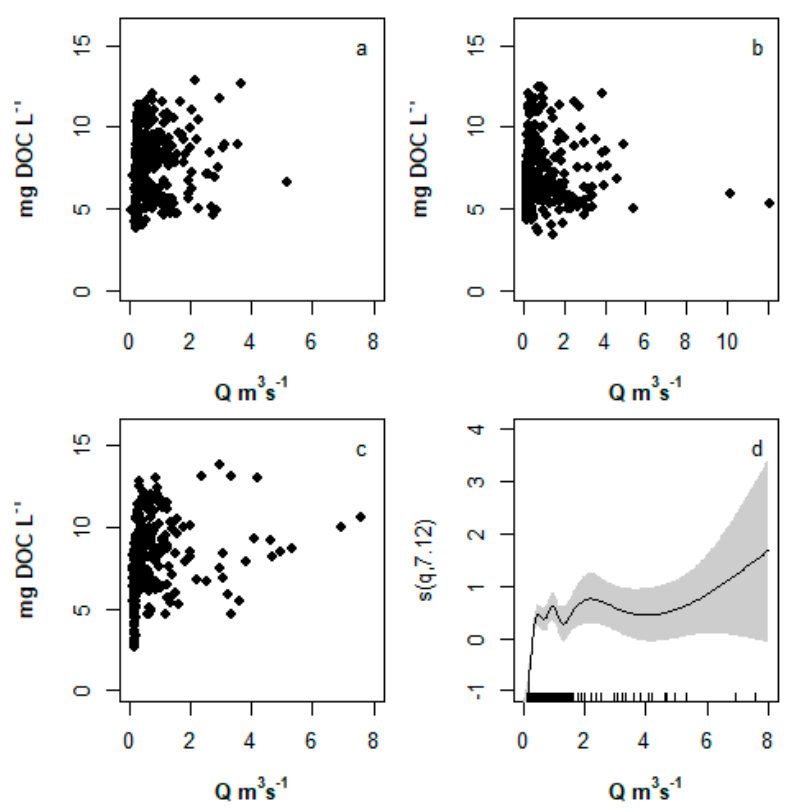
Figure 4. The relationship between stream discharge (Q) and estimated DOC concentration at a daily time step for ( a ) 2004, ( b ) 2006, and ( c ) 2010; ( d ): the smoother for the relationship between discharge and estimated DOC concentrations for 2010 (the solid line is the smoother and the grey area is the 95% confidence band in this plot). The y axis is the centered smoother, showing the estimated degrees of freedom (7.12) for the model in brackets.